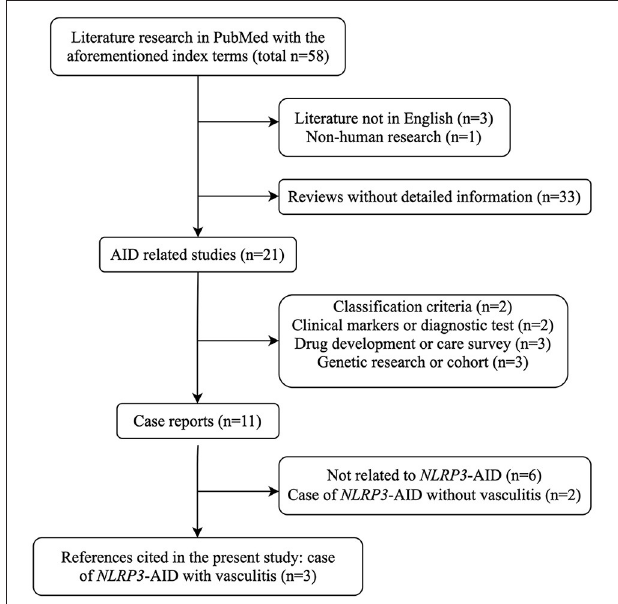
FIGURE 1 | Flow chart of literature research strategy with the index terms mentioned. AID, autoinflammatory disease; NLRP3 -AID, NLRP3 -associated autoinflammatory